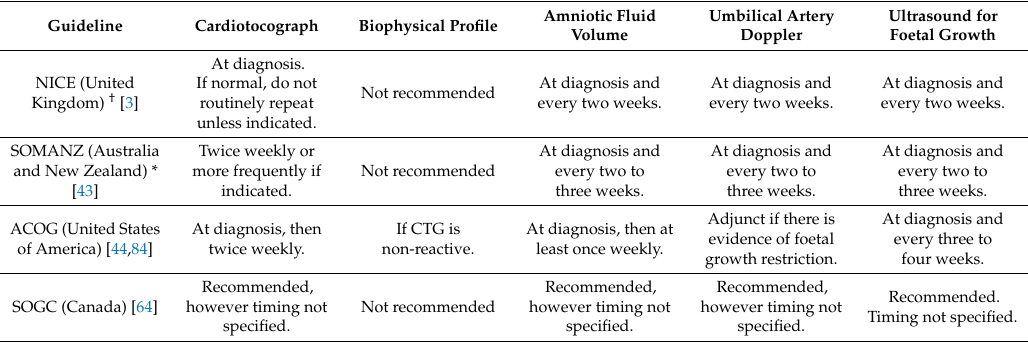
Table 2. Routine recommendations for foetal surveillance in preeclampsia without severe